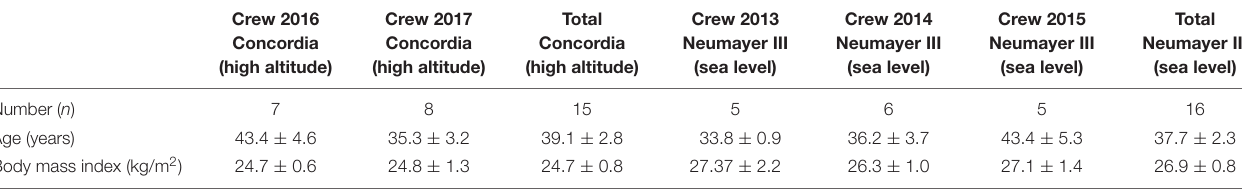
TABLE 1 | Demographic data of participants of the respective campaign and Antarctic station at